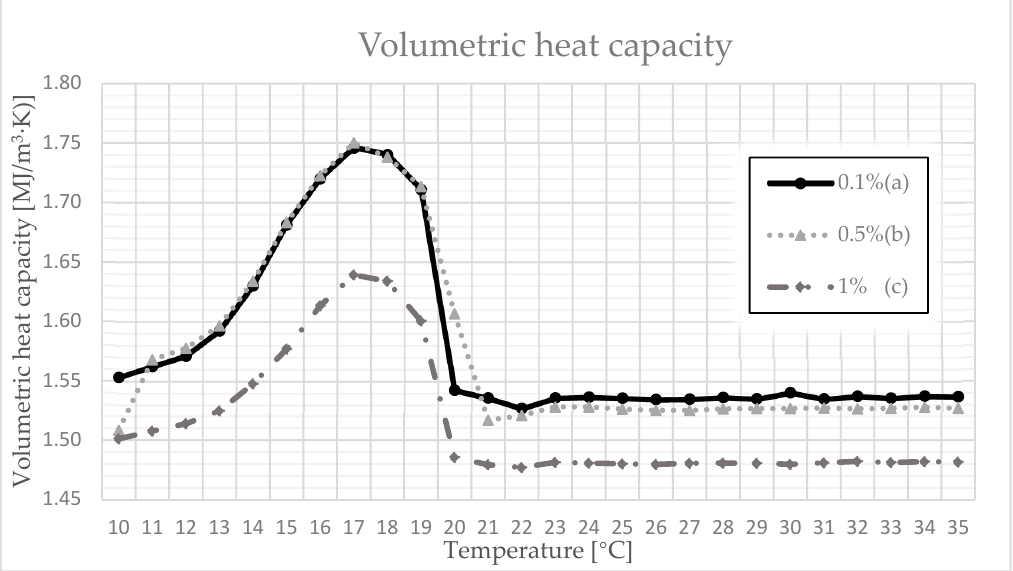
Figure 4. Volumetric heat capacity as a function of temperature for (a) 0.1% polymer; (b) 0.5% polymer; and (c) 1% polymer.